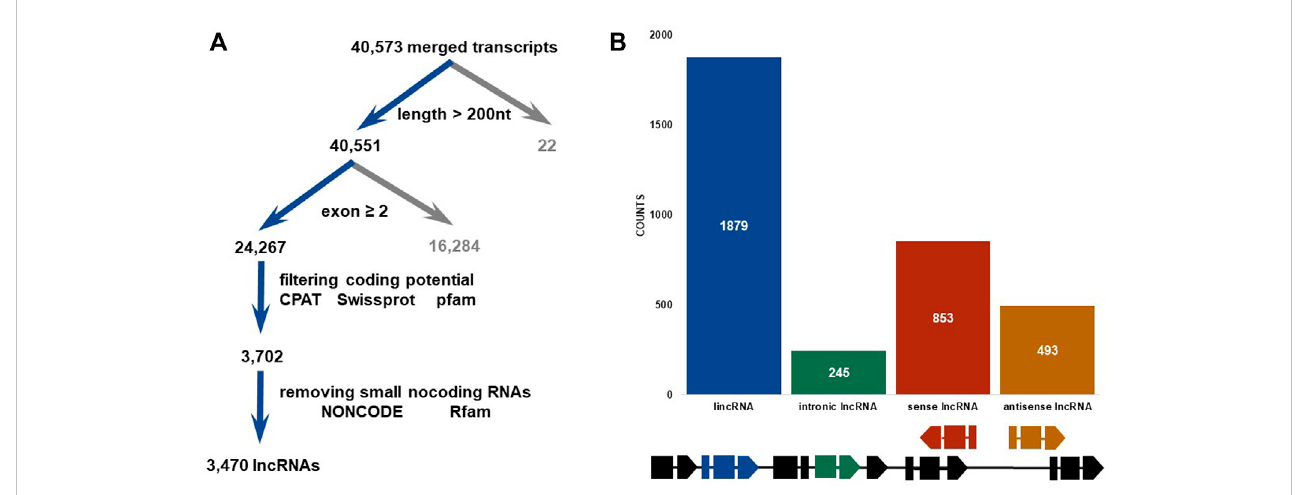
FIGURE 1 Identi fi cation and classi fi cation of lnc RNAs in SSB. (A) Brief computational pipeline for identifying lncRNAs. (B) Histogram of lncRNAs categorized as lincRNA(longintergenicnon-codingRNA),introniclncRNA,senseexonlncRNA,andantisenseexonlncRNA.Theschematicdiagramatthebottomshowsthe differences of the gene structure of different types of lncRNAs in the